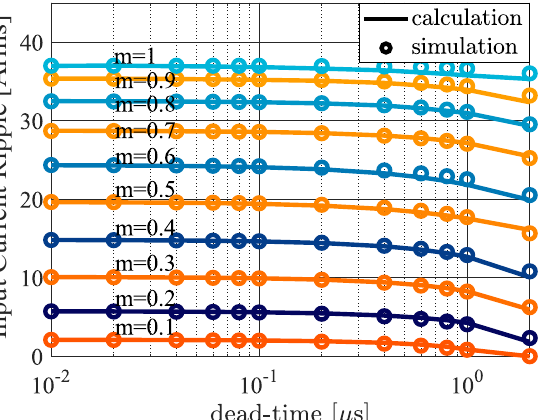
Figure 9. Calculation and simulation results of dead-time vs. rms input current ripple of the three- phase VSI (case 2